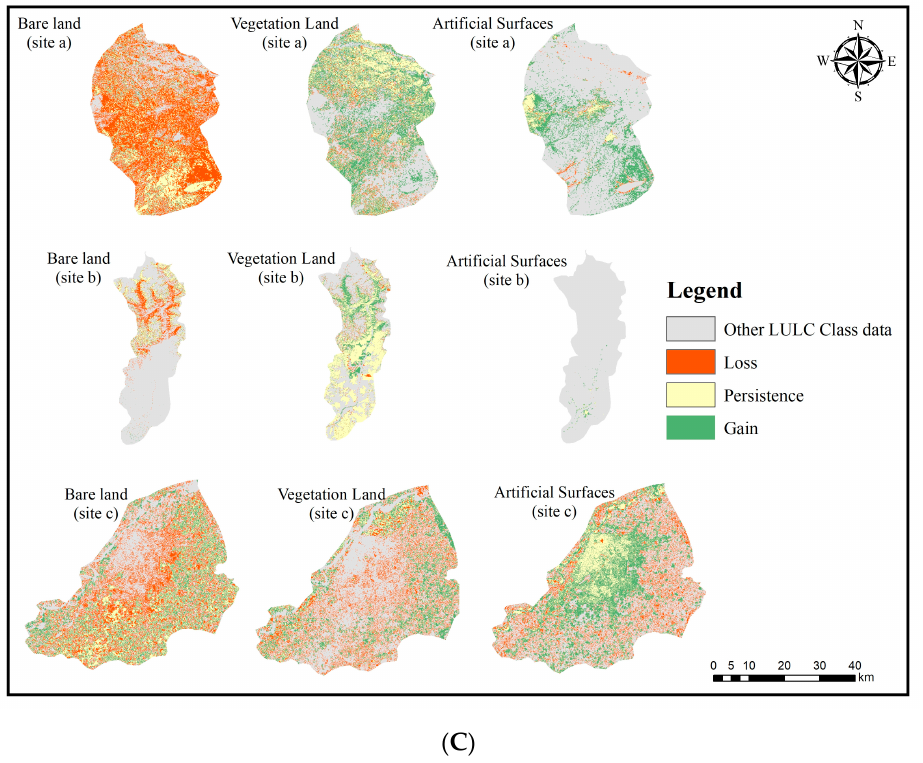
Figure 5. ( A ) Gain and loss for all LULC classes over KPK province from 2000–2020: (a) cultivated land, (b) vegetation, (c) water bodies, (d) artificial surfaces, (e) bare land, and (f) permanent snow and ice. ( B ) Gain and loss for all LULC classes over Punjab province from 2000–2020: (a) cultivated land, (b) vegetation, (c) water bodies, (d) artificial surfaces, and (e) bare land. ( C ) Gain and loss for all LULC classes over 2000–2020: sites (a) Peshawar (top), (b) Swat (middle), and (c) Lahore (bottom).